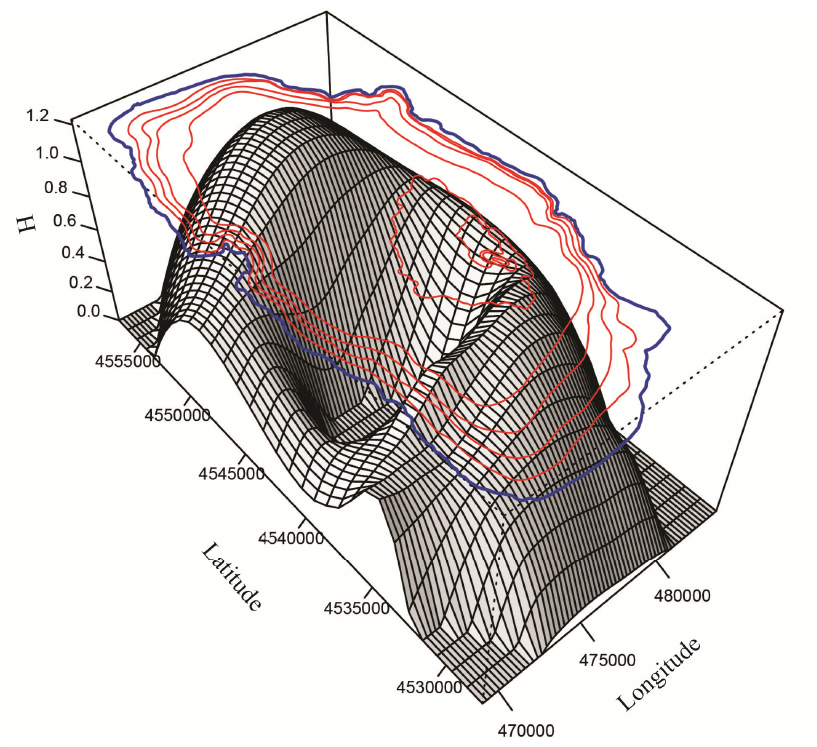
Figure 10. Spatially modeled species diversity (H) in Lake Ohrid.